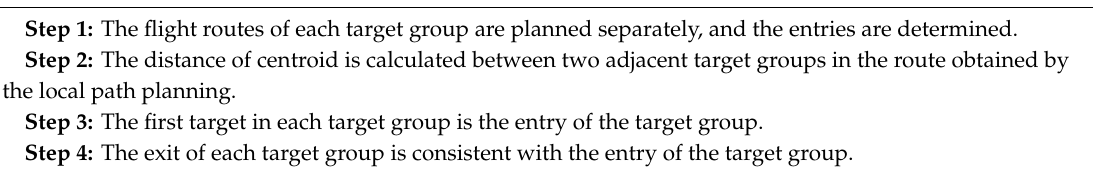
Algorithm 3: The strategy for determining entry and exit in the target